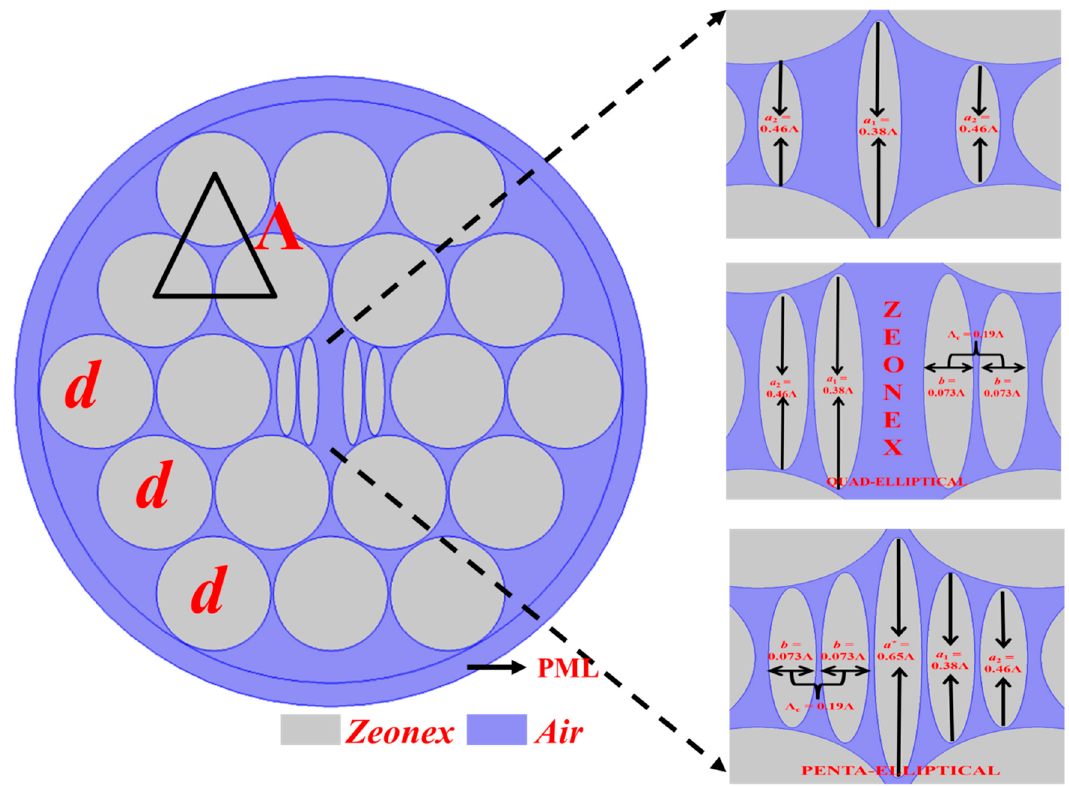
Figure 1. Geometrical cross section of the proposed tri-elliptical (TE), quad-elliptical (QE), and penta-elliptical (PE) porous core photonic crystal fibers (PC-PCFs). PML, perfectly matched layer.